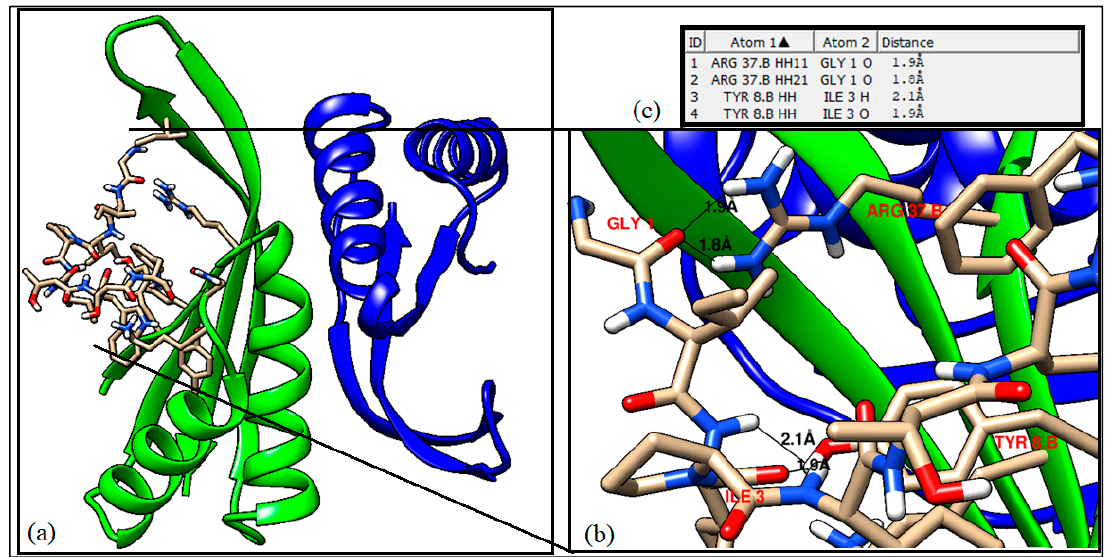
Figure 8. ( a ) Docking structure of predicted T cell epitope with ternary complex ( b ) Interacting amino acid residues in docking structure with hydrogen bonds ( c ) Atoms participate in hydrogen bonds with their bond distances. Table 8. Details of H bonds between ternary structure and T cell epitope. Sl No.